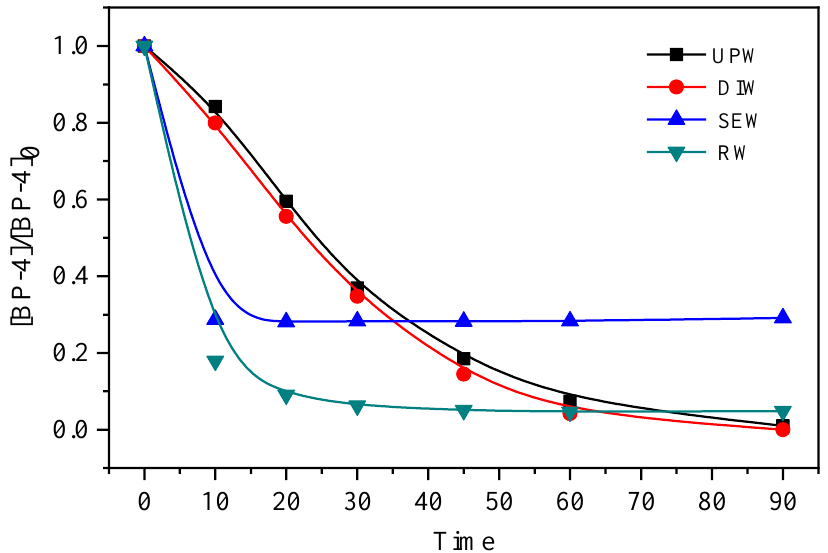
Figure 5. Removal of BP-4 from water samples by Fe(VI) at a molar ratio of 100:1 ([Fe(VI)] 0 :[BP-4] 0 ). (abbreviations: UPW — ultrapure water; DIW — deionized water; SEW – secondary effluent of sewage treatment plant; RW — Jiaxing Canal River Water.).